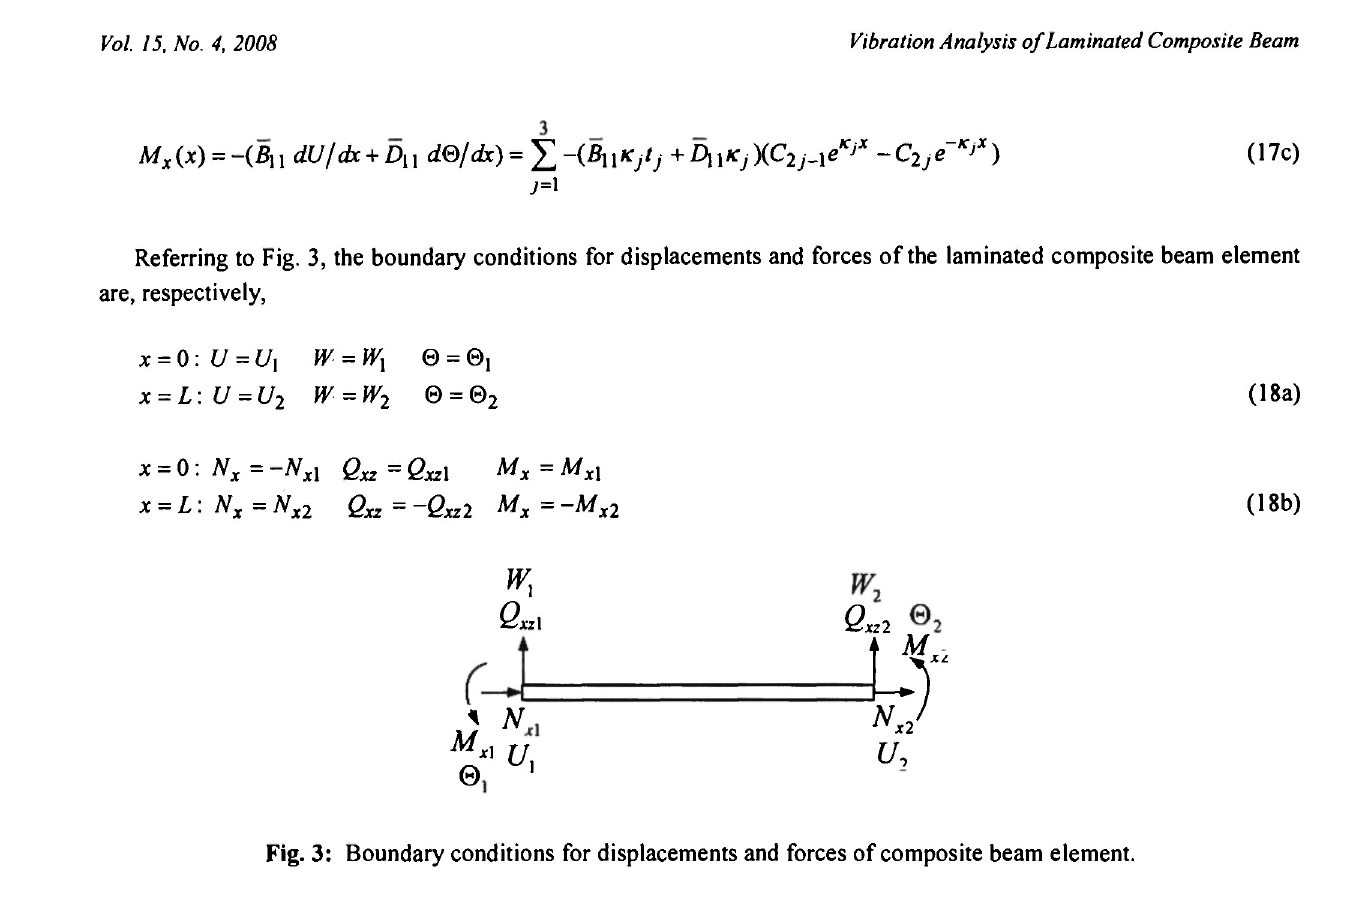
Fig. 3: Boundary conditions for displacements and forces of composite beam